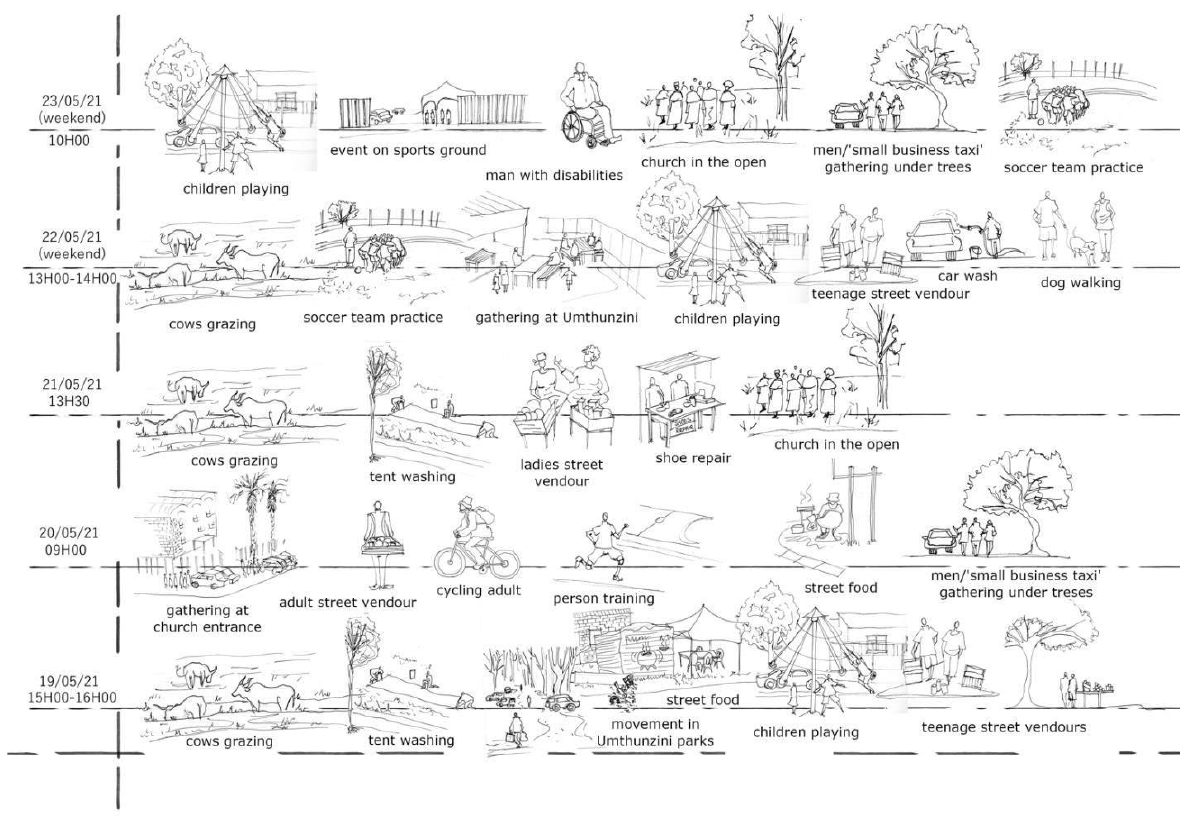
Figure 6. Activity mapping along open space network in Mamelodi east (Demba,